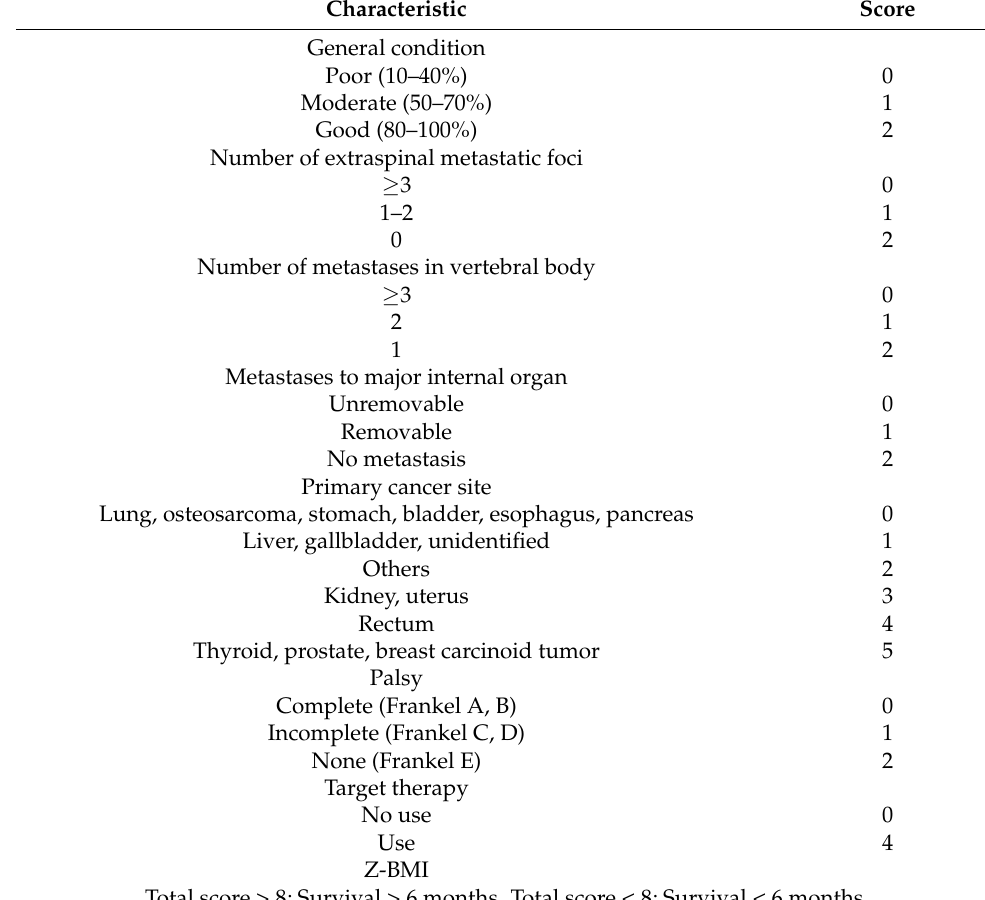
Figure 2. The conceptual of the two-step test. Abbreviation: RTS = revised Tokuhashi score; ATS = adjusted Tokuhashi score.